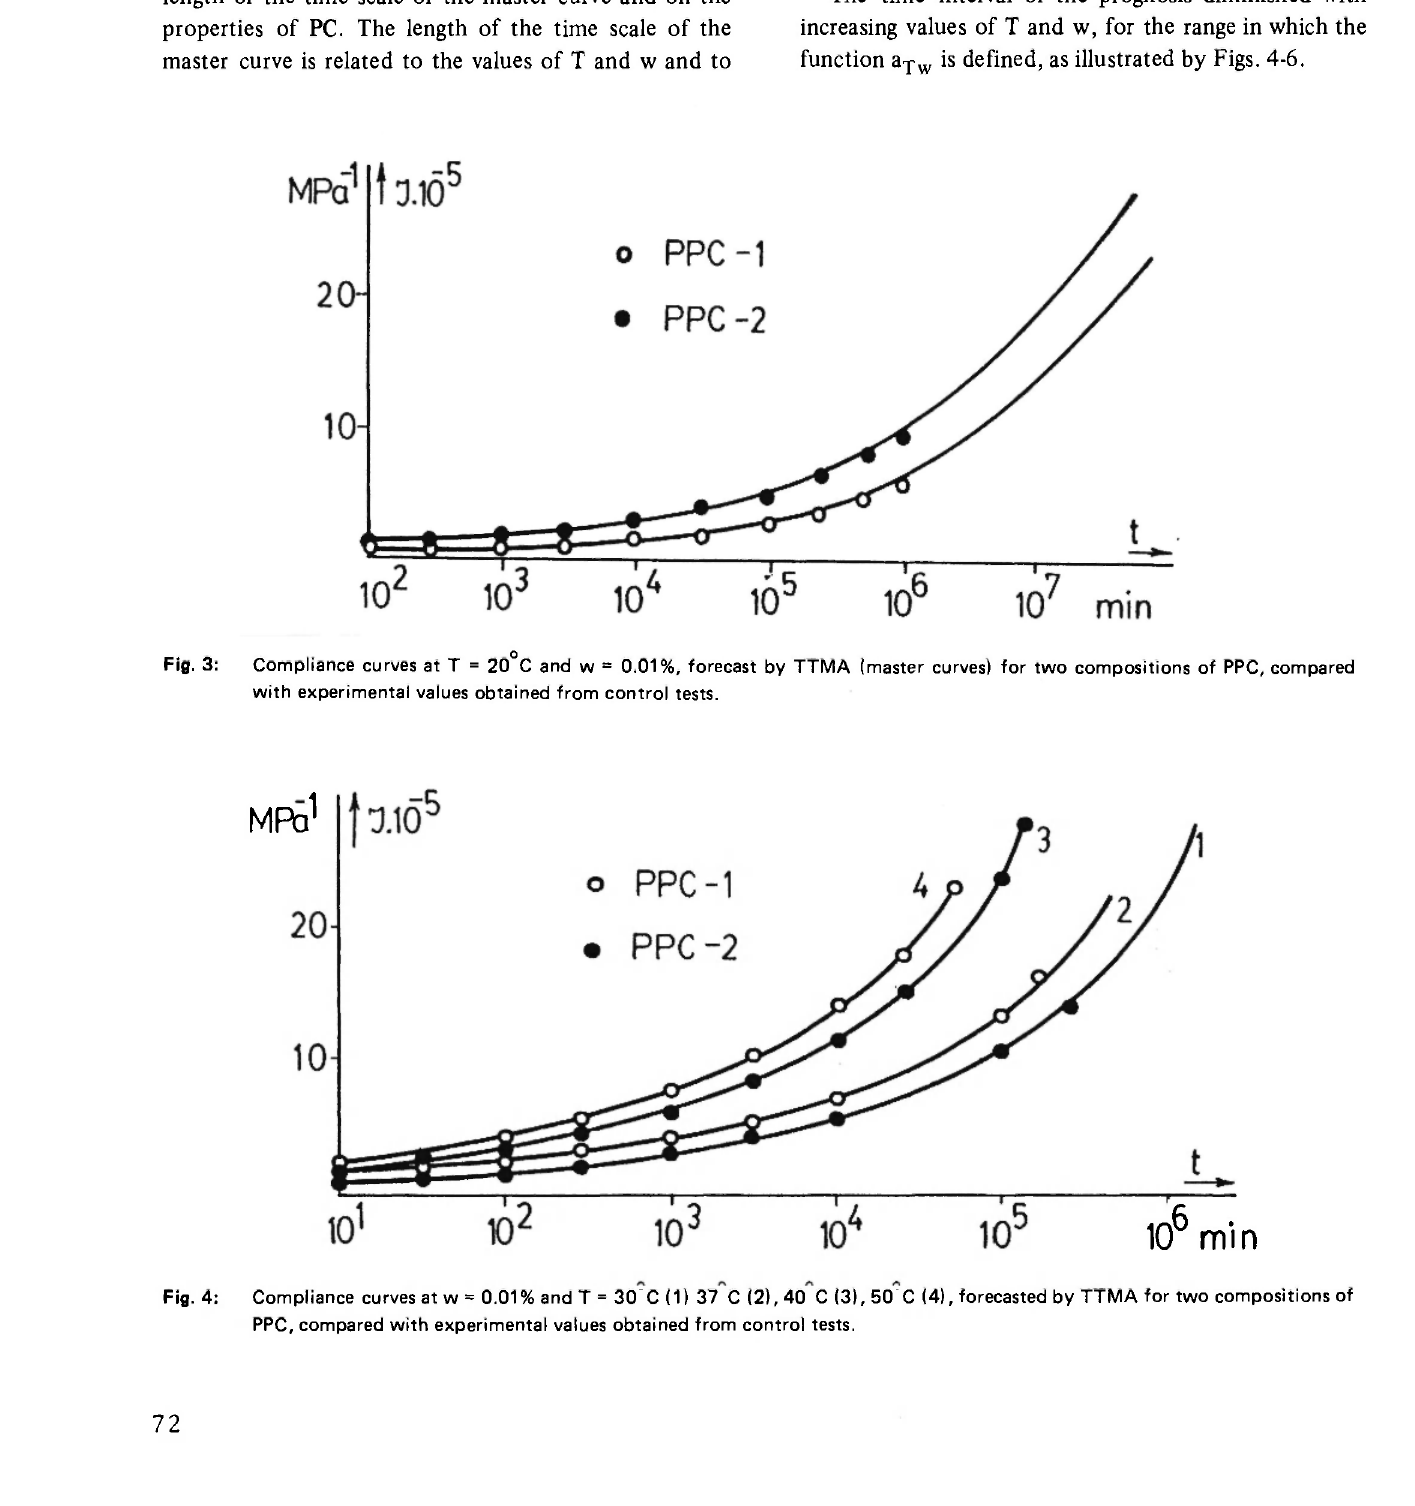
Fig. 4; Compliance curves at w = 0.01% and Τ = 30 C (1) 37 C (2), 40 C (3), 50 C (4), forecasted by TTMA for two compositions of PPC, compared with experimental values obtained from control